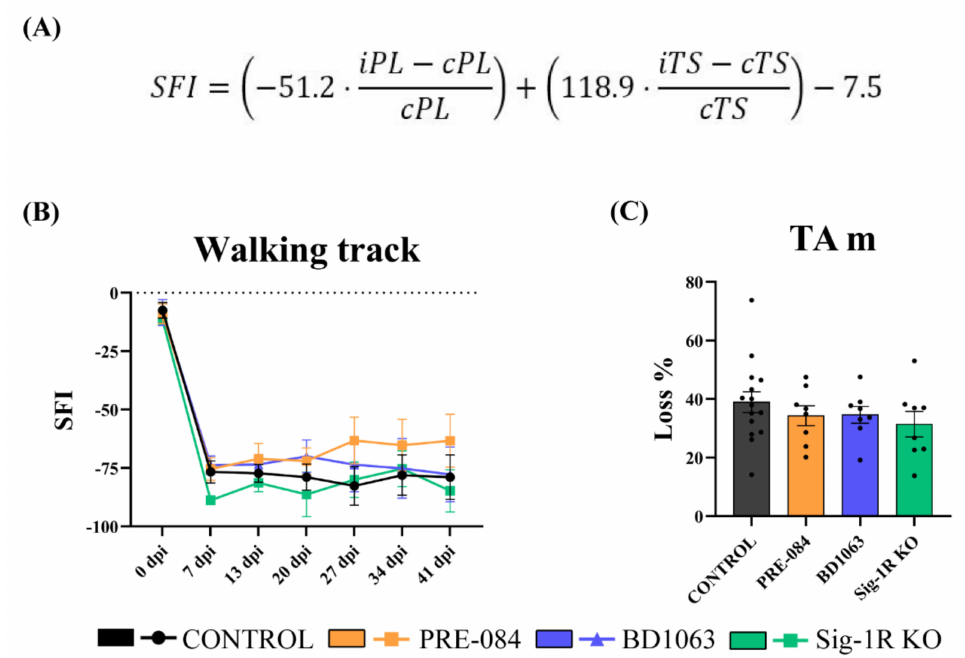
Figure 2. Functional evaluation after injury. ( A ) Sciatic functional index (SFI) is a measure of the pattern of hind paw stepping during locomotion, and requires an appropriate reinnervation of paw flexor/extensor muscles of the ankle and the toes after sciatic nerve injury. (i: ipsilateral paw; c: contralateral paw; PL: print length; TS: toe spread between 1st and 5th toes); ( B ) Plot of the walking track-derived SFI of the different groups of mice with Sig-1R ligands, and Sig-1R KO. Values at 0 dpi correspond to basal values from the test performed before the injury; ( C ) Percentage of weight loss of the TA muscle ipsilateral to injury with respect to the contralateral muscle at 42 dpi. Values are mean ± SEM; PRE-084 (n = 8), BD1063 (n = 8), Sig-1R KO group (n = 8) and control group (n =